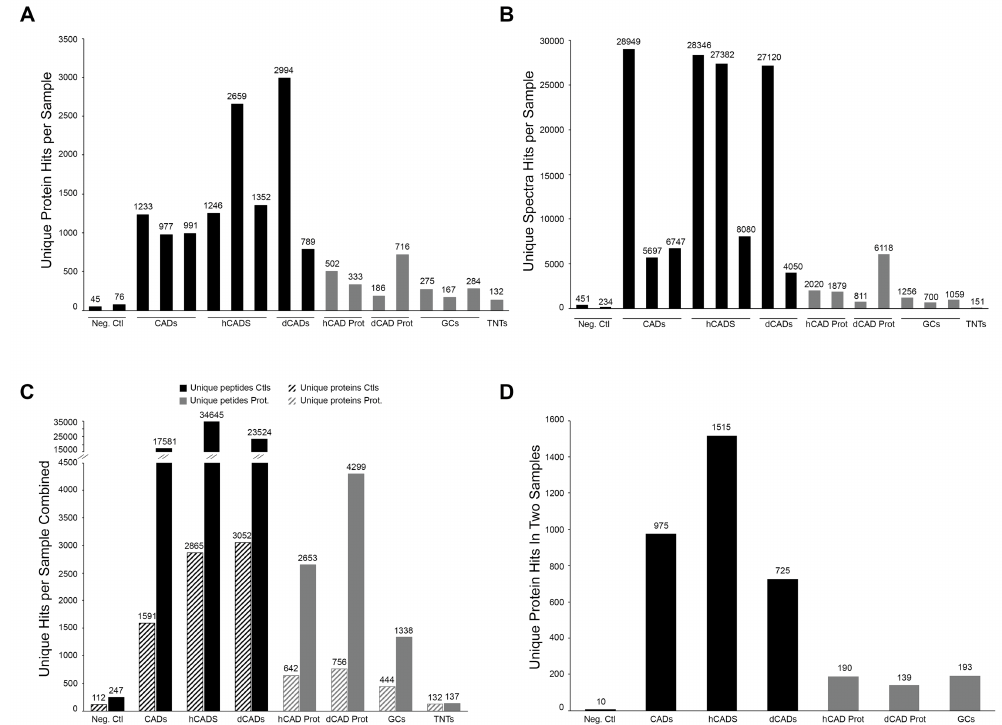
Figure 2. LCM/MS Microproteomic data. MS data were obtained for 18 different samples. ( A ) The number of Unique Protein or ( B ) Spectra Hits per sample are shown. ( C ) The number of unique proteins and peptide hits for all of the samples combined are represented. ( D ) A representation of the unique protein hits in at least two samples is shown. High quality/quantity of identified proteins with our DTBP-fixed samples are observed. The TNT LCM/MS data from glutaraldehyde-fixed cells resulted in mostly single peptide hits per identified